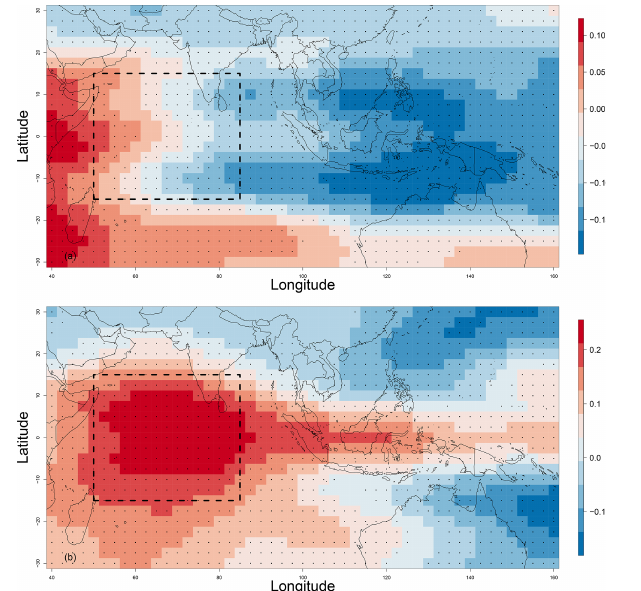
Figure 2. The optimal domain of computation of analogs. We com- puted analogs over the Indian Ocean, in the geographic areas indi- cated by the dashed black rectangle with coordinates 15 ◦ S–15 ◦ N, 50–85 ◦ E. The figure shows the temporal correlation between Z500, RMM1 (a) , and RMM2 (b) for the whole studied period from 1979 to 2020. The correlation is weak, but it is still significant, with p values ≤ 0 . 05 that we indicate with black dots over each grid of the considered domain (including the optimal region used to compute